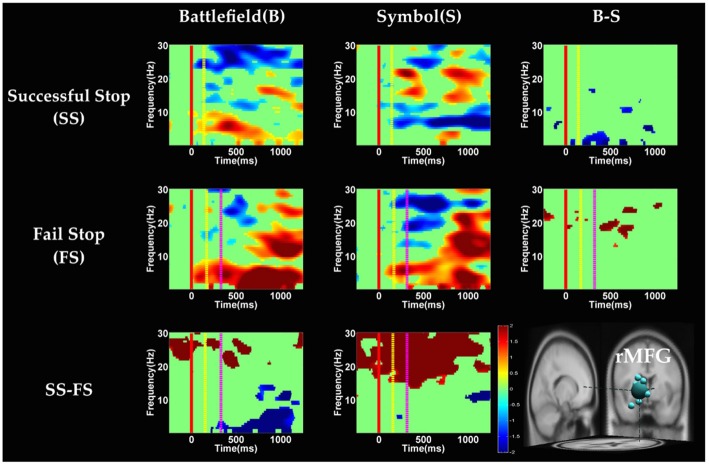
The ERSP images of rMFG cluster under error detection. Red solid line: onset of the go stimulus; yellow dash line: onset of the stop signal; purple dash line: onset of response; color bars indicate the magnitude of the ERSPs; statistical threshold at p < 0.01.